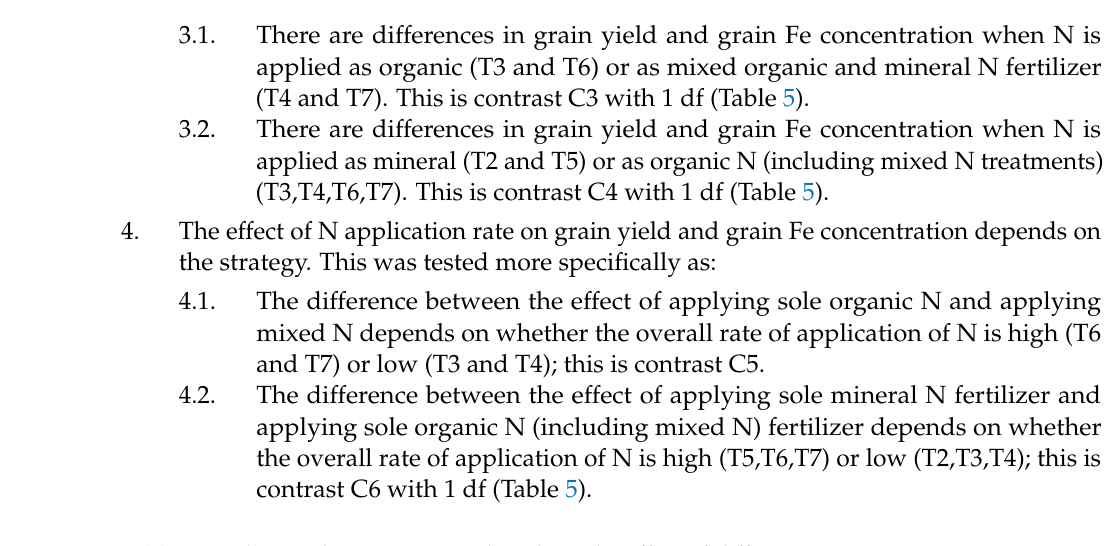
Table 5. Orthogonal contrasts tested to show the effect of different N management strategies on maize, two finger millet “seed pools”, and cowpea productivity and grain Fe concentration. Contrast Comparison * df C1 0 N versus some N fertilizer application Low N versus High N fertilizer Organic N fertilizer versus mixed N